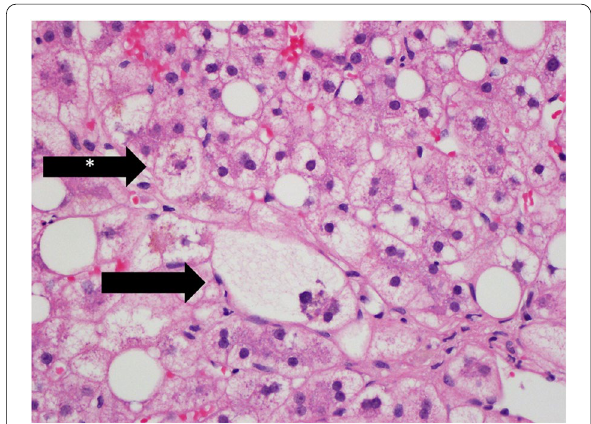
Fig. 3 De novo Non‑alcoholic steatohepatitis (NASH) with both large ballooned hepatocyte (black arrow) and small ballooned hepatocytes (black arrow with star)